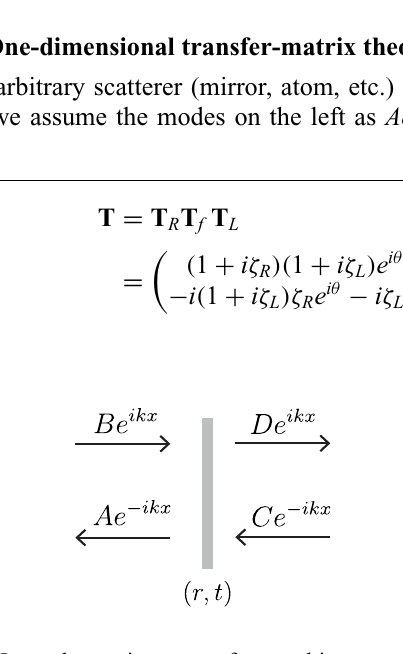
FIG. 14. In- and outgoing waves for an arbitrary scatterer with reflectivity and transmission coefficients ( r , t )